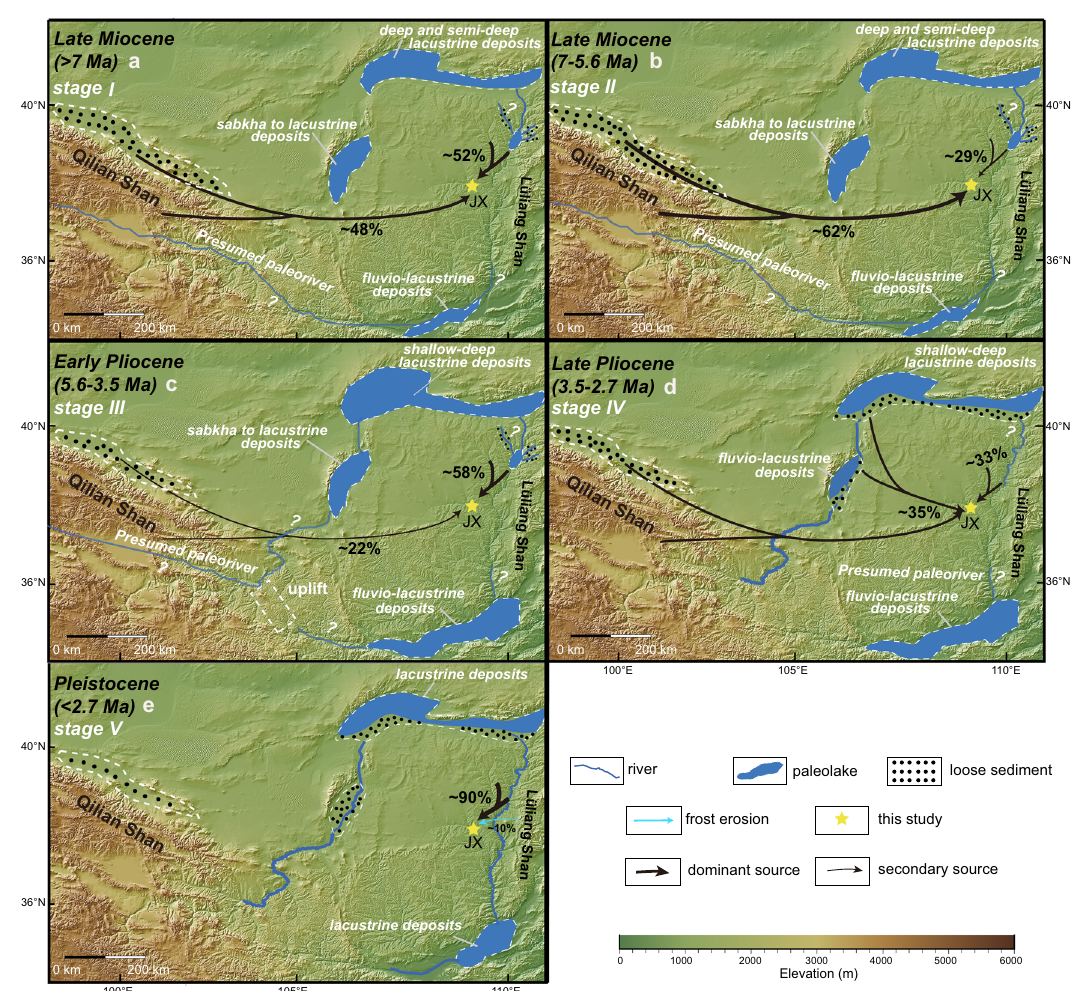
Fig. 7 Schematic diagram showing dust provenance changes in JX and corresponding surface processes. The basemap was produced by an open- source software GMT 63 . The regional topography was produced by the SRTM datasets 64 . The yellow star indicates the location of the Jiaxian site (JX). a Stage I: Similar contributions from erosion of local basement (Cretaceous sandstone overlying the North China Craton) and distal source (Qilian Shan of northeastern Tibetan Plateau). b Stage II: Increased Qilian Shan exhumation and global cooling increased distal contribution. c Stage III: Decreased Qilian Shan exhumation and climatic wetting decreased erosion and distal contribution. Following uplift in the Lanzhou area and possible rerouting of the upper Yellow River course 44 , more northeastern Tibetan Plateau-derived sediments were routed towards the Yinchuan-Hetao graben. However, climate warming and wetting promoted lacustrine environments to prevail 45 . Thus, northeastern Tibetan Plateau-derived sediment was temporarily stored in the paleolake(s) in the Yinchuan-Hetao graben, resulting in decreased distal contribution and dust accumulation rate. d Stage IV: Climatic dry-wet fl uctuations ampli fi ed, resulting in increased erosion and release of trapped sediments in the Yinchuan-Hetao graben, increasing the distal contribution. e Stage V: Following the onset of intensive Northern Hemisphere glaciations, increased wet-dry contrast in comparison with the Pliocene increased river erosion, and released more unconsolidated sediments from the local basement. Climatic fl uctuation amplitude increase promoted middle Yellow River incision, resulting in a connection between the middle and upper Yellow River. Increased erosion of the Lüliang Shan by frost wedging and other weathering processes enhanced during glacial intervals resulted in more production of unconsolidated